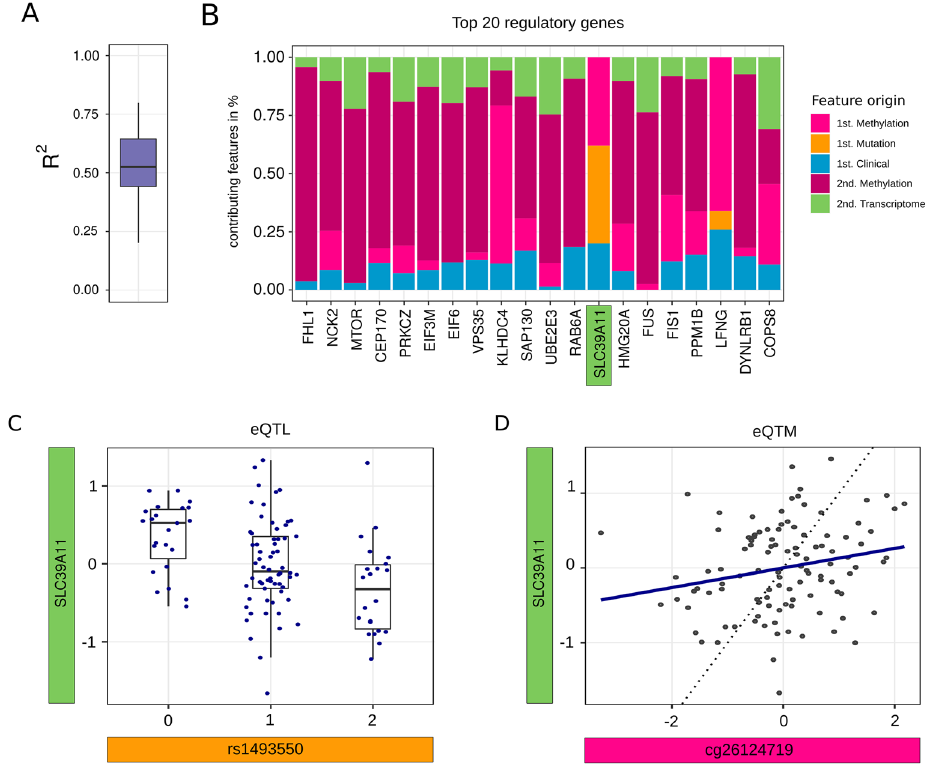
Figure 6. ( A ) Performance of n = 20 genes with the highest betweenness and ( B ) its composition of retained features deriving from omic levels for each gene. Gene expression with possible influence by ( C ) SNP and ( D ) methylation site found with KiMONo; the dotted line represents a correlation of 1.